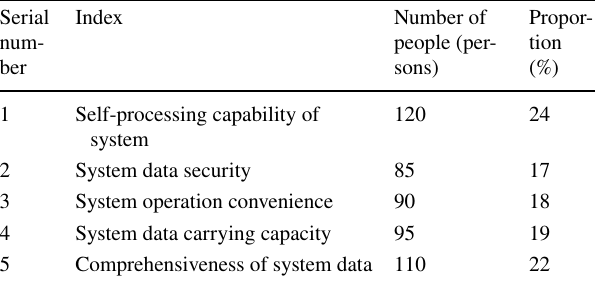
Table 2 Questionnaire results of football injury management and